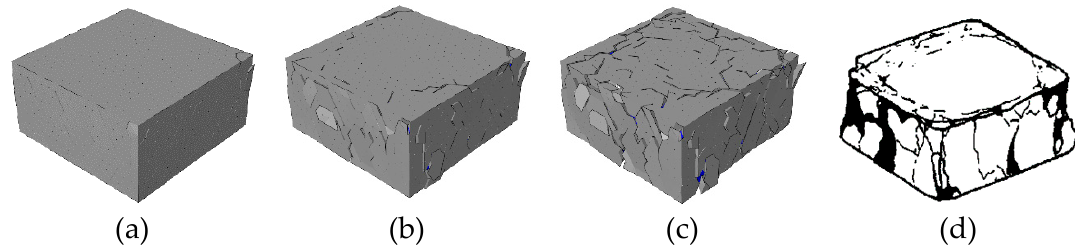
Figure 23. Fracture pattern (aggregate in blue and cement matrix in gray) of the concrete specimen with 50 mm height at different states in Figure 20: ( a ) state D, ( b ) state E, ( c ) state F, and ( d ) the final fracture pattern in experiments [46].